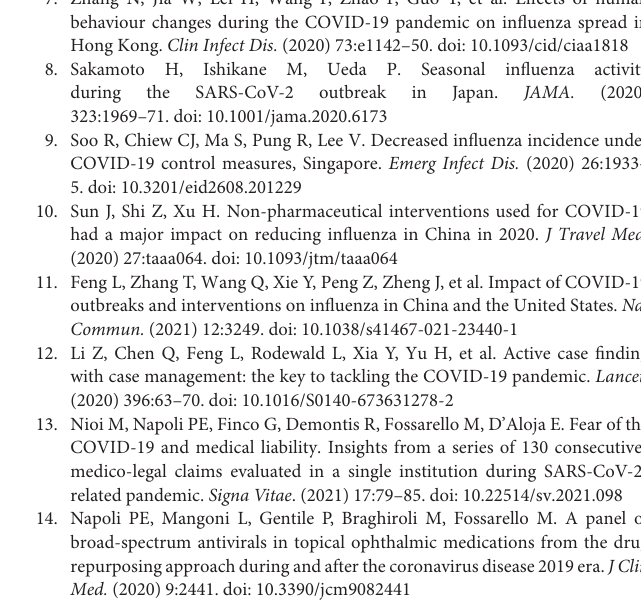
Supplementary Table 3 | Characteristics of infectious